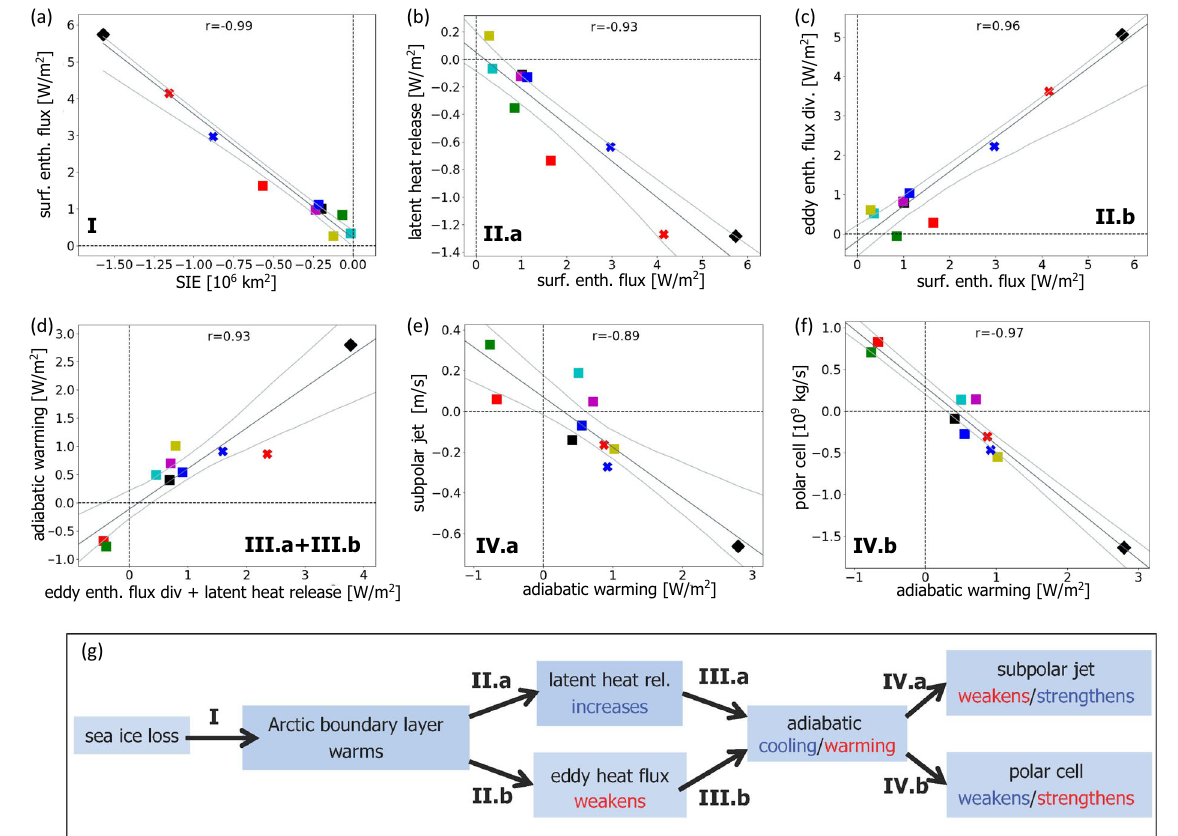
Fig. 4 Feedback mechanism behind the enhanced pan-Arctic climate response. a Scatter plot of the Arctic-mean surface enthalpy fl ux anomaly against the total Arctic sea-ice extent anomaly for all the future Arctic experiments [arrow I in schematic ( g )]. Both quantities are computed over an Arctic polar cap north of 60°N. Anomalies are computed as the differences between the ensemble mean in each future Arctic experiment and the ensemble mean in the present-day control. The least-square regression line and its 95% con fi dence envelope are included as thin black lines. b – f As in a but between the anomalies of: b Arctic-mean latent heat released by precipitation ( L v P ) [arrow II.a] and surface enthalpy fl ux. c Arctic-mean tropospheric eddy heat fl ux divergence and surface enthalpy fl ux [arrow II.b]; d Arctic-mean tropospheric adiabatic warming and the combined effect of latent heat released by precipitation and tropospheric eddy heat fl ux divergence [arrow III]; e subpolar jet [arrow IV.a] and Arctic-mean tropospheric adiabatic warming; and f polar cell strength and Arctic-mean tropospheric adiabatic warming [arrow IV.b]. g Schematic diagram of mechanism detailing how pan-Arctic or regional sea-ice loss in fl uences the zonal-mean tropospheric circulation (blue/red fonts refer to climate response associated with adiabatic cooling/warming). On a – f are shown: future Arctic (black diamond), Central Arctic (black square), Barents – Kara (red square), Irminger – Nordic (yellow square), Hudson – Baf fi n and Labrador (magenta square), Beaufort – East Siberian – Laptev (green square), Bering – Chukchi (blue square), Okhotsk (cyan square), Central Arctic and Barents – Kara (red cross), and all Arctic except Central Arctic seas (blue